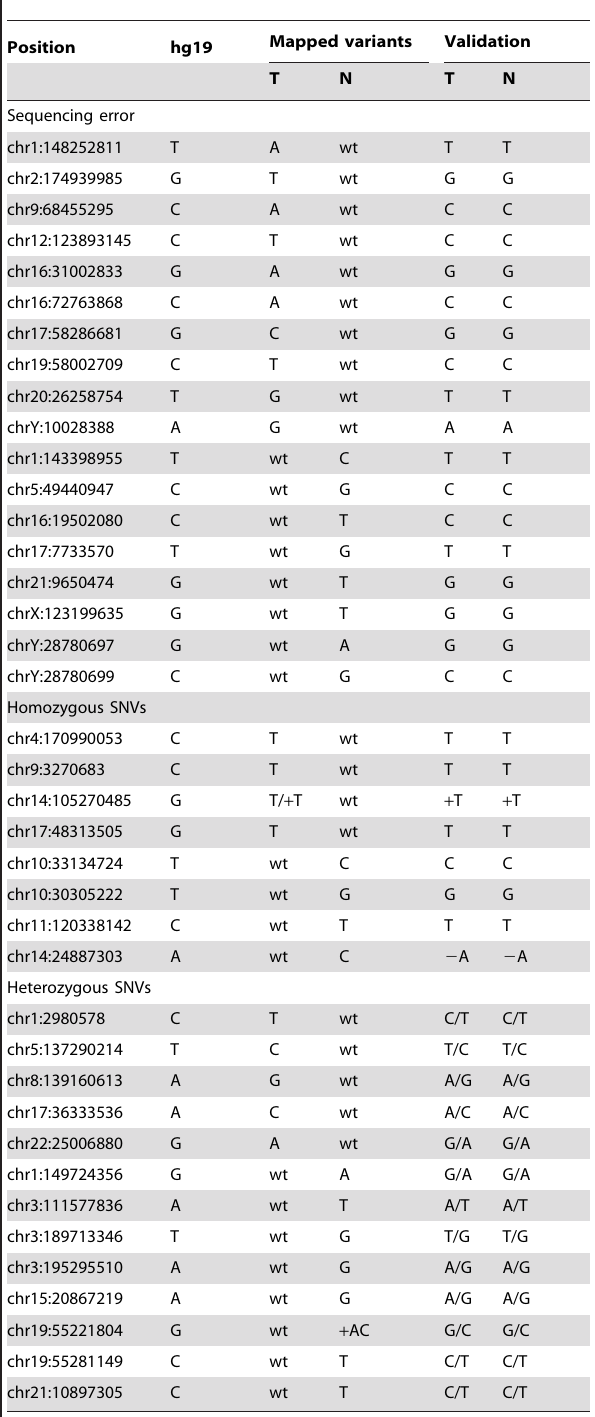
Table 3. Sanger sequencing validation for single-base differences between neutrophils and T cells.*